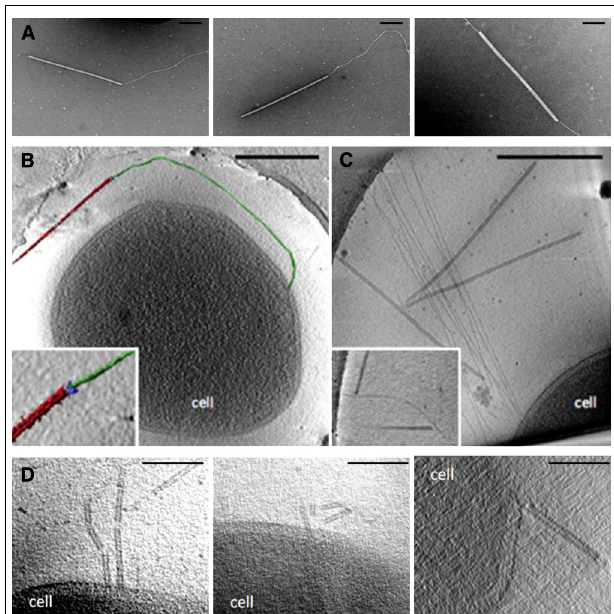
FIGURE 1 | Entry of SIRV2 in S. islandicus LAL14/1 cells. (A) Transmission electron micrographs showing that SIRV2 virions interact with purified cellular filaments. Stained with 2% uranyl acetate for 2 min. Scale bar, 200 nm. Electron micrographs of SIRV2 interaction with S. islandicus LAL14/1 cells. Samples were collected 1 min post-infection and flash-frozen for electron cryotomography (cryo-ET). The virions interact both at the filament tips (B) and along the length of the filaments (C) . The lower left panel (B) also shows a segmented tomographic volume of the SIRV2 virion (red) attached to the tip of an S. islandicus filament (green). The three terminal virion fibers that appear to mediate the interaction are shown in blue (the inset depicts a magnified view of the interaction between the virion fibers and the tip of the filament). The inset in the lower right panel (C) depicts two virions bound to the sides of a single filament. Scale bars, 500 nm. (D) Tomographic slices through S. islandicus LAL14/1 cells at 1 min after infection with SIRV2 reveals partially disassembled SIRV2 virions at the cell surface. Adapted from (Quemin et al., 2013). Scale bar, 100